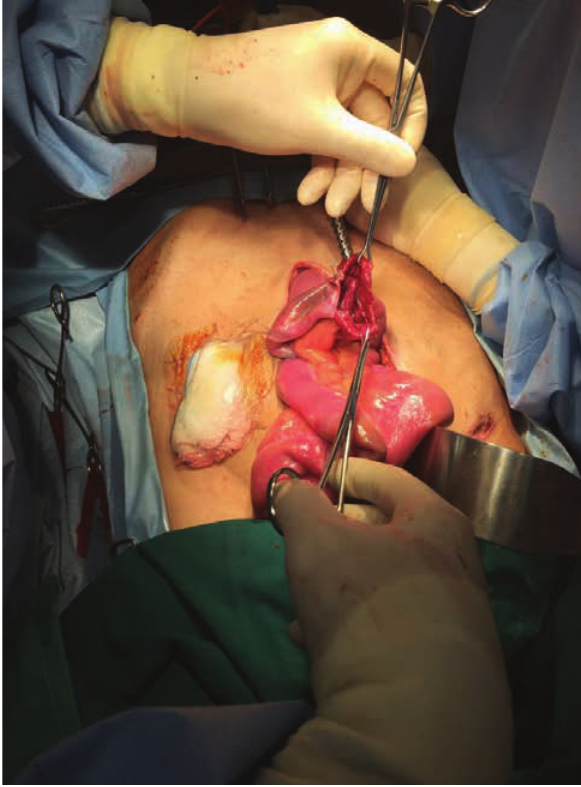
Figure 3: (Case 1) Intraoperatively, large perforation noted at the distal ileum, proximal to the covering ileostomy. There was genera- lised purulent peritonitis.